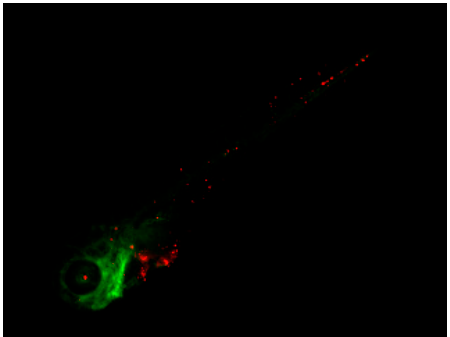
Figure 2. Representative image of MDA-MB-231 cell line five days after injection into the duct of Couvier of 2 day post fertilization (dpf), Tg ( fli1 : GFP ) ZF embryo. MDA-MB-231, labeled in red, were